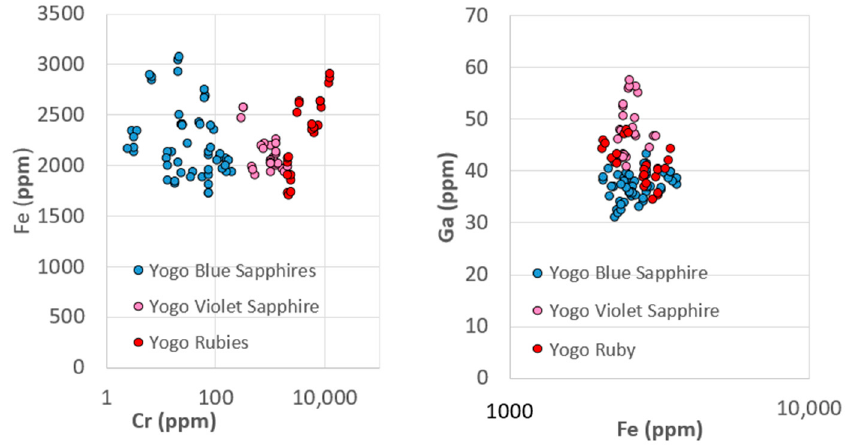
Figure 7. Plots of trace element chemistry of blue and pink sapphires and rubies from Yogo Gulch, Montana, showing their characteristic trace element ranges.